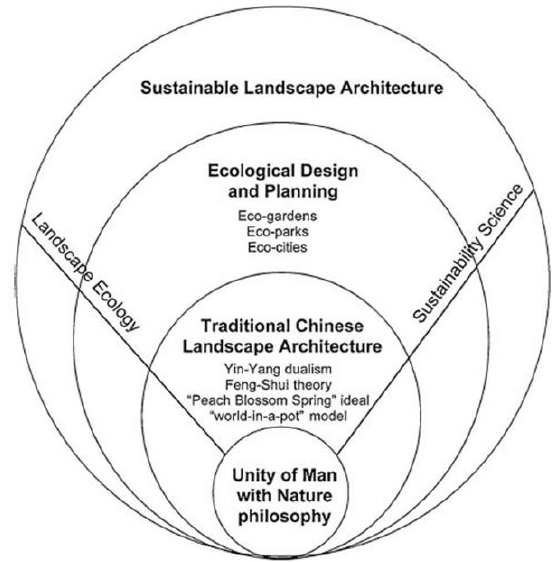
Figure. 1. Conceptual framework for a sustainable Chinese landscape architecture.Source (Xu, et al.,